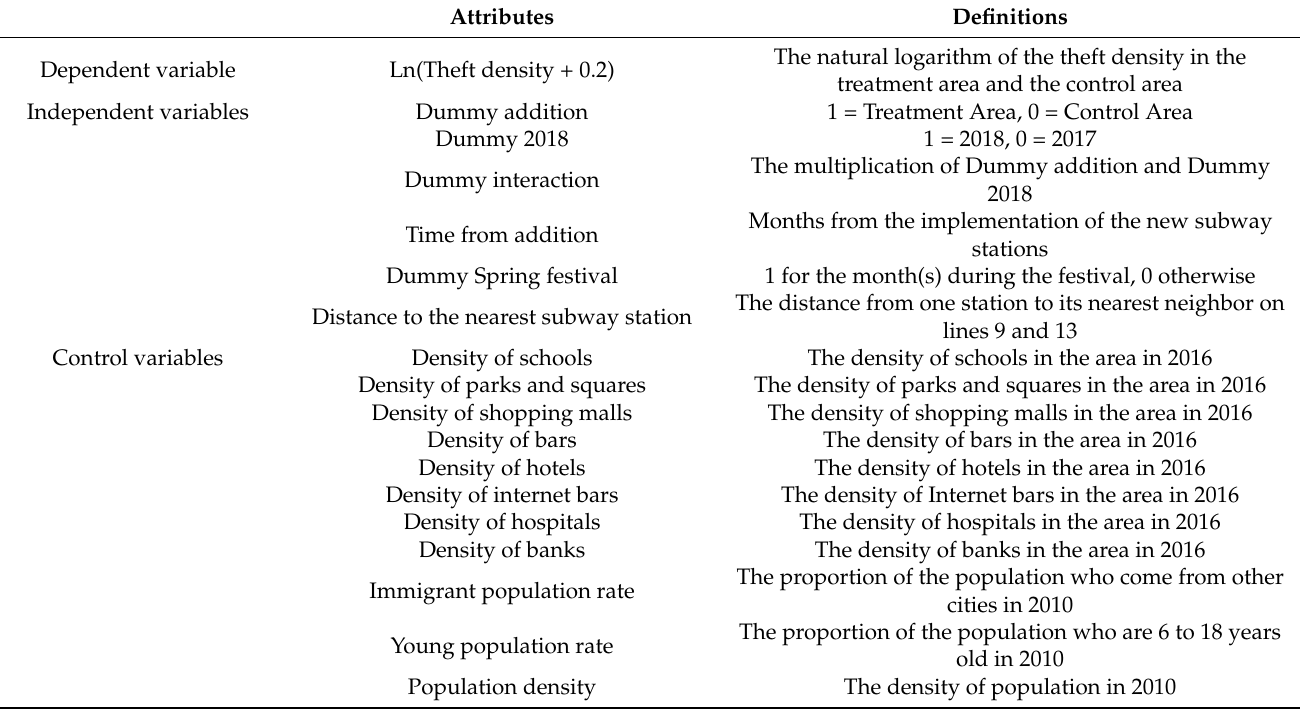
Table 2. The attributes and definitions of